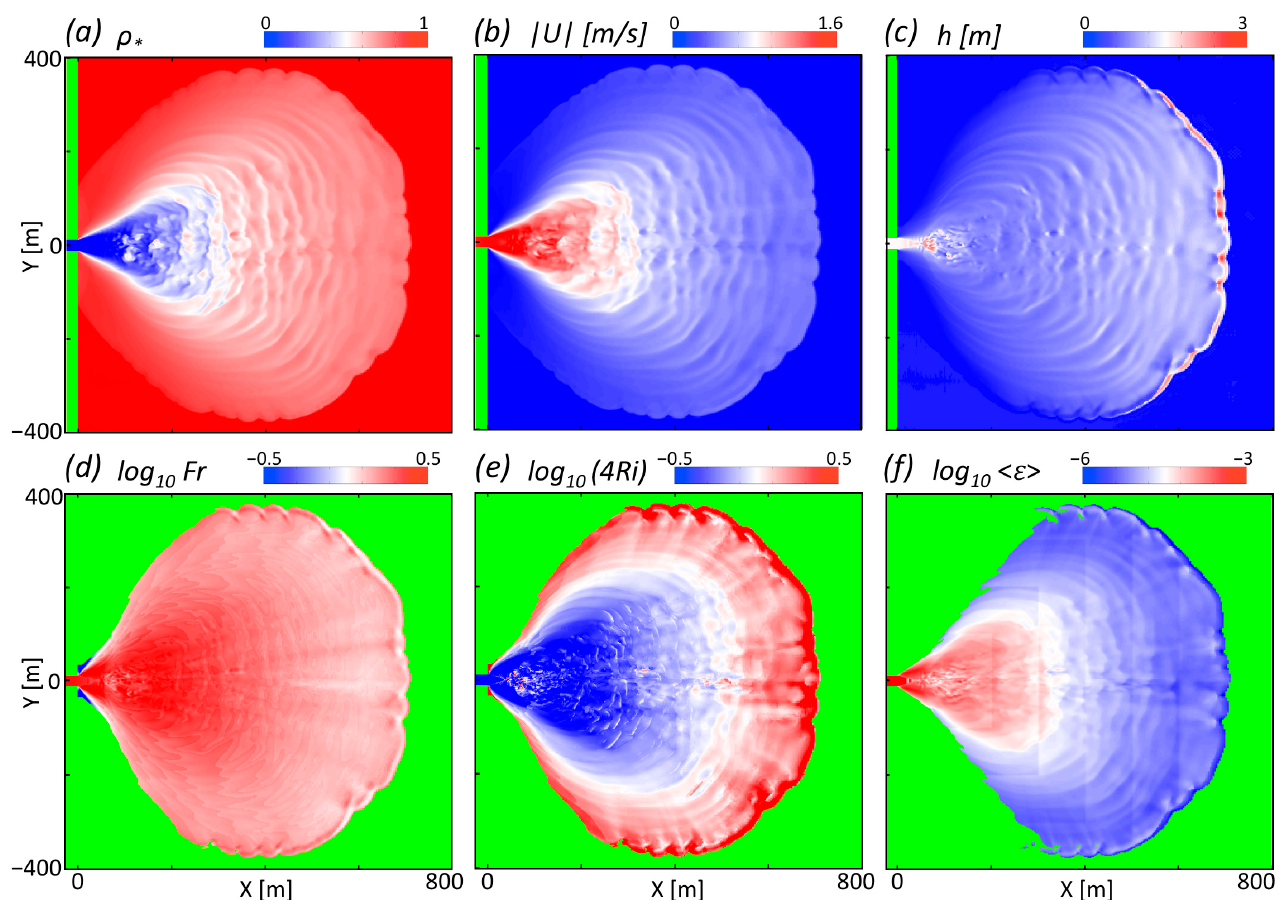
Figure 3. Representative model results, shown at t = 1630 s. ( a ) surface normalized density, 𝜌 ⁎ ; ( b ) surface velocity magnitude, | U |; ( c ) plume depth h , defined as where the normalized density 𝜌 ⁎ = 0.9; ( d ) Froude number, Fr; ( e ) Richardson number, Ri; ( f ) kinetic energy dissipation rate 𝜖 , averaged over plume depth h ; discontinuities in 𝜖 occur at jumps in the model grid spacing.